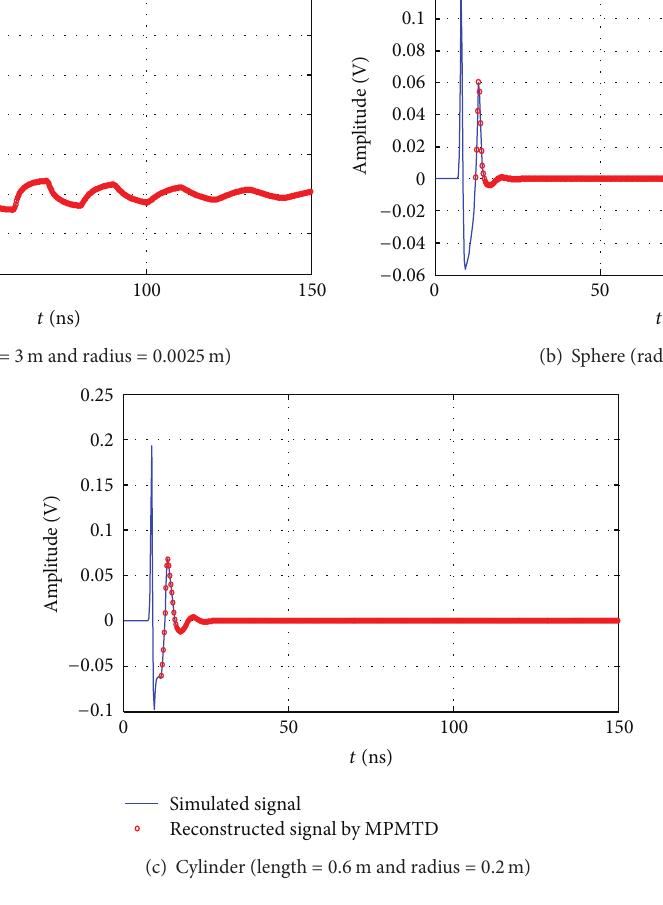
Figure 2: Simulated signal compared with reconstructed signal by MPMTD for a sphere (radius = 0.3 m).